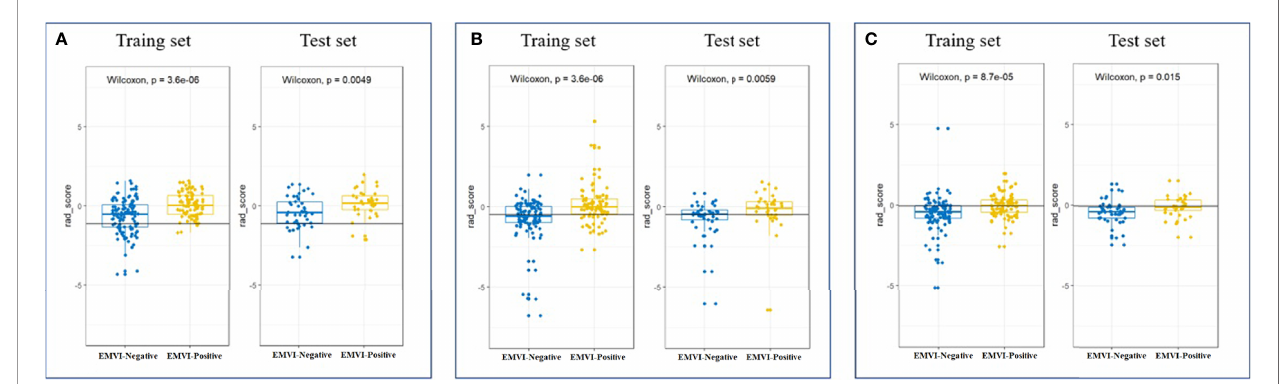
FIGURE 4 | Scatter plot between EMVI-negative (blue dots) and EMVI-positive (yellow dots) rad scores calculated by radiomics signatures constructed by T2WI (A) , CE-T1WI (B) and CT-enhanced images (C) in the training and test sets.